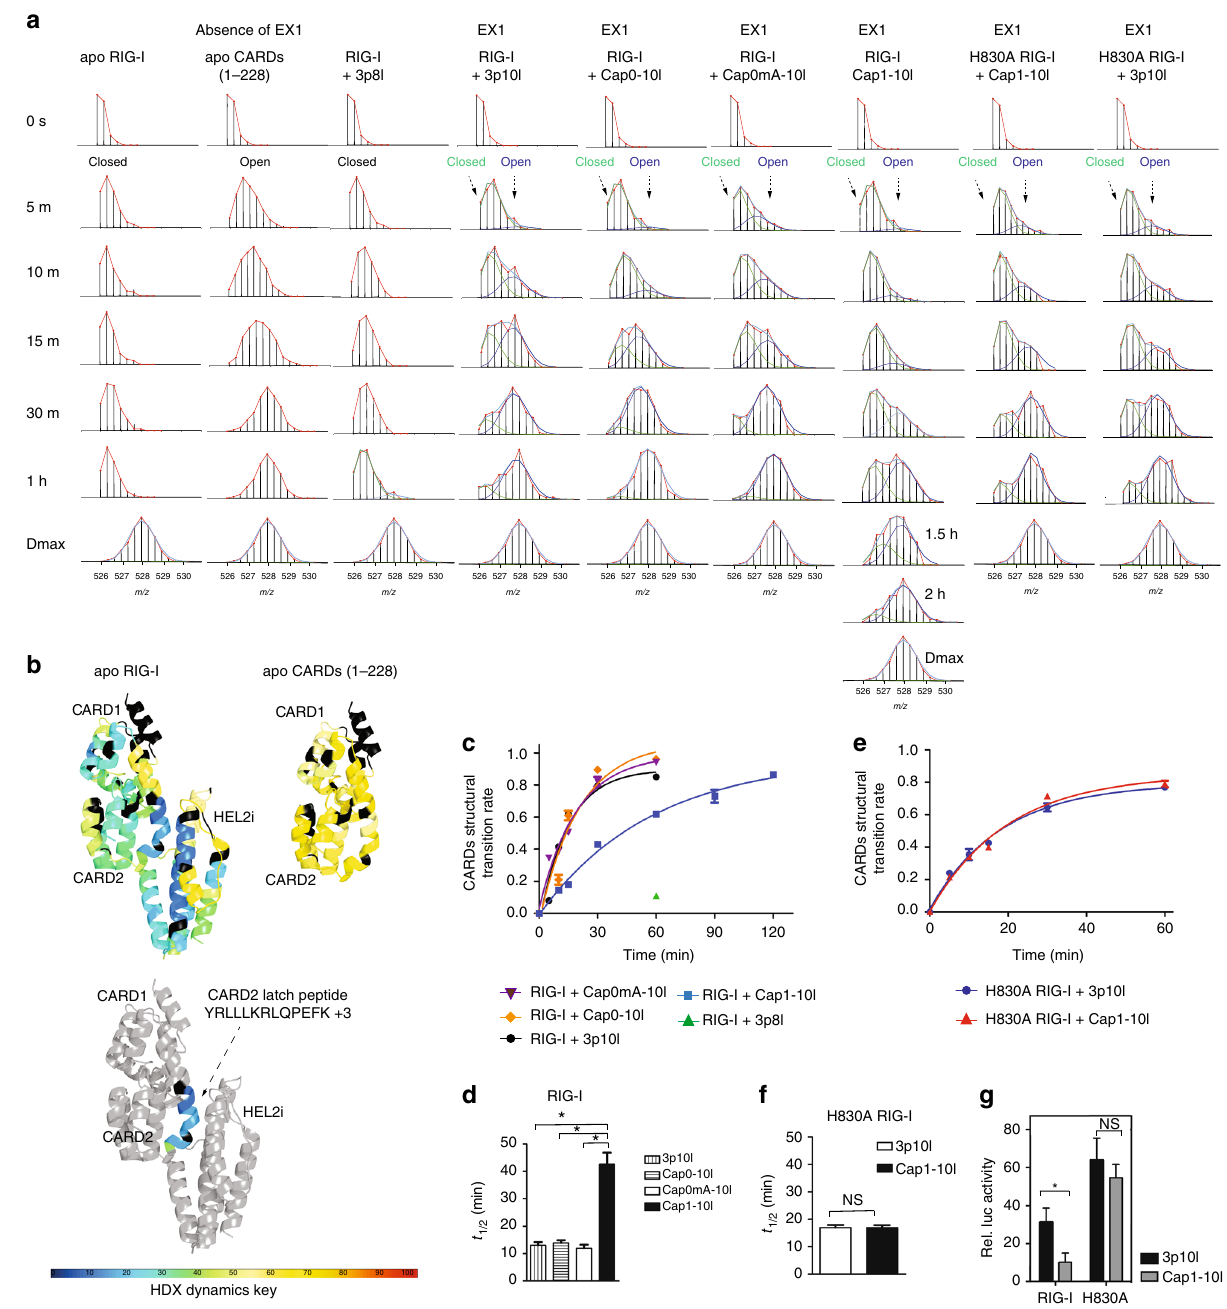
Fig. 2 Partial opening of CARDs upon RNA surveillance by WT and H830A RIG-I. a MS spectra of RIG-I CARD2 latch peptide Y103 – 114 derived from various complexes at the indicated on-exchange time points. b HDX single amino acid consolidation view of apo RIG-I (Supplementary Fig. 1a, b and c, column (i) and (ii)) are, respectively, mapped to the CARDs-HEL2i structure model (upper left panel) and single CARDs structure (upper right panel), representing auto-repressed and solvent-exposed CARDs conformational dynamics. The location of CARD2 latch peptide is highlighted in the structure model (below). Percentages of deuterium uptake are color coded according to HDX dynamics key. Black, regions that have no sequence coverage and include proline residue that has no amide hydrogen exchange activity. c and e The fraction of WT or H830A RIG-I CARDs molecules in the higher MS population (open conformation) to the total population is plotted against the on-exchange time points. d , f Half-life ( t 1/2 ) of respective partial opening event is determined by fi tting an exponential 3P with the prediction model: a + b × exp( c .time(min)), where a is the asymptote, b is the scale, and c is the growth rate, is used to fi t a curve to %D (response) and time (regressor). Inverse prediction is used to solve for the half-life ( t 1/2 ) for each conformational state. (*Means that Cap1-10l-treated group predicted t 1/2 (42.53 min) was higher than the upper limit (24.67, α = 0.05), whereas 3p10l ATP, Cap0-10l, and Cap0mA-10l-treated groups did not exceed the lower or upper limits in this comparison; NS means statistically nonsigni fi cant between compared group. t 1/2 calculated for 3p10l-bound H830A RIG-I and Cap1-10l-bound H830A RIG-I did not exceed the lower or upper limits ( α = 0.05) in this comparison.) g The IFN- β luciferase signal is plotted as recorded in WT/H830A RIG-I dual reporter assays stimulated with indicated RNAs. The signi fi cance of differences between groups was evaluated by Student ’ s t test (* p < 0.05; ** p <